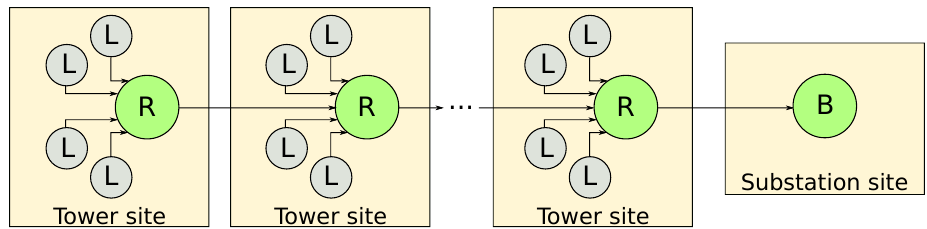
Figure 4. The node arrangement in the context of multipath